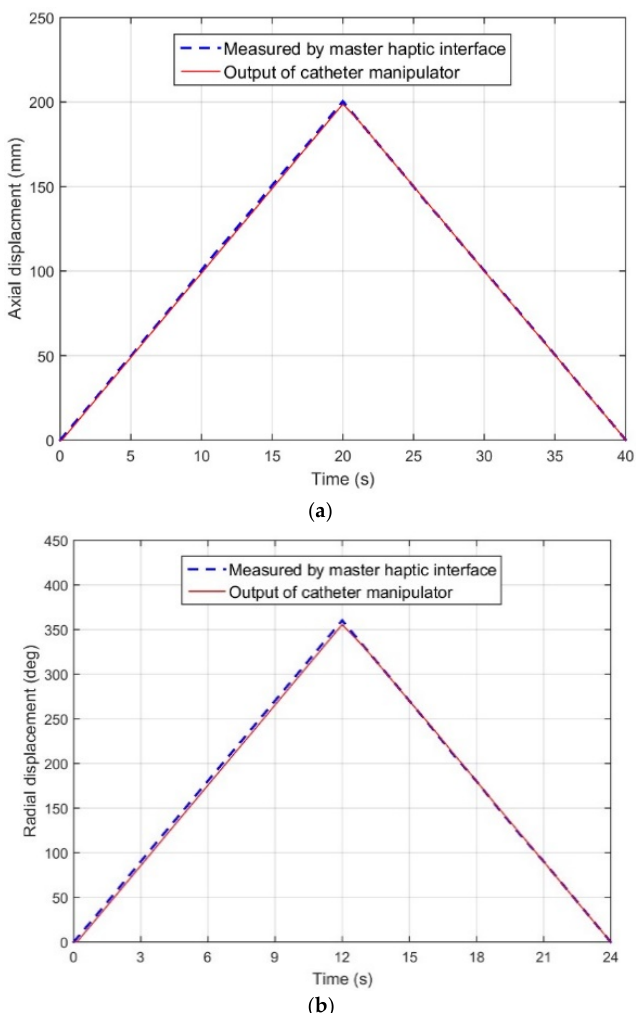
Figure 14. The delay characteristics catheter intervention and rotation between the haptic-based master system and the slave catheter robotic-assisted system. ( a ) Is in axial direction (speed is 10 mm/s) and ( b ) is in radial direction (speed is 30 deg/s). Table 3. Time delay between the master haptic interface and the catheter manipulator.